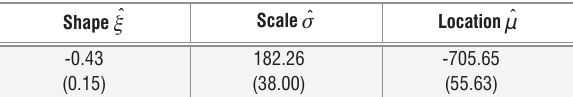
Posterior means (standard deviations) of the generalised extreme value distribution